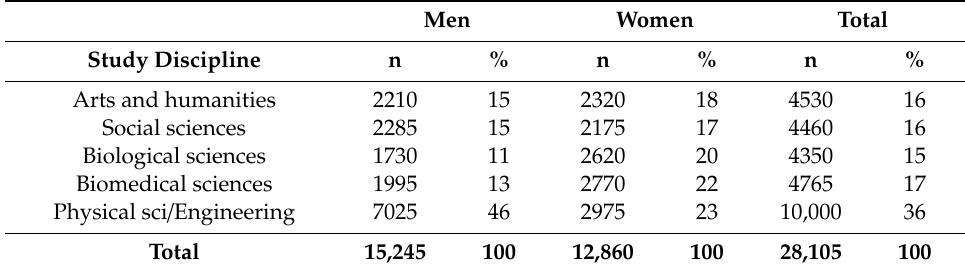
Table A1. Adapted from: Higher Education Students Statistics (HESA), 2019. (HESA